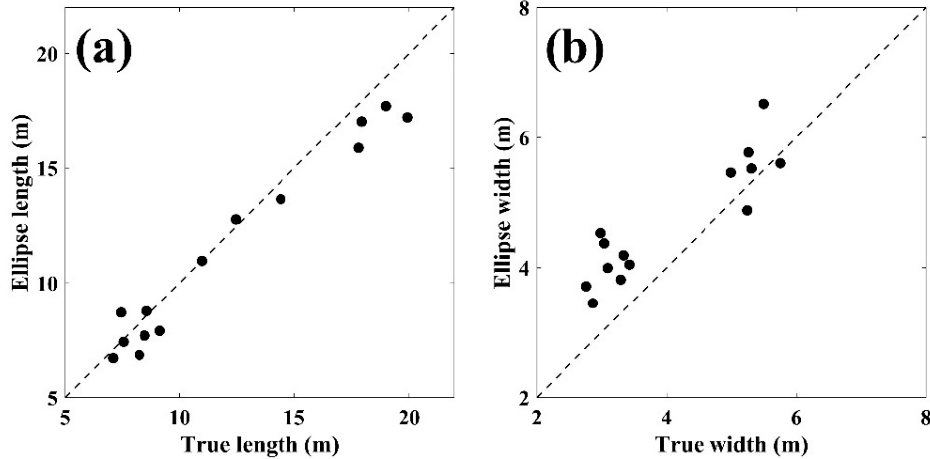
Figure 13. Comparison of ( a ) length and ( b ) width of vessels estimated by ellipse fitting.